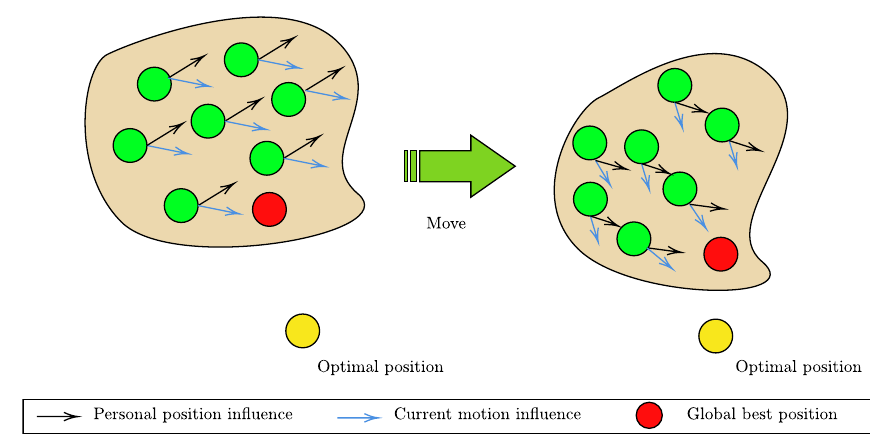
Fig. 7 Particle swarm optimization